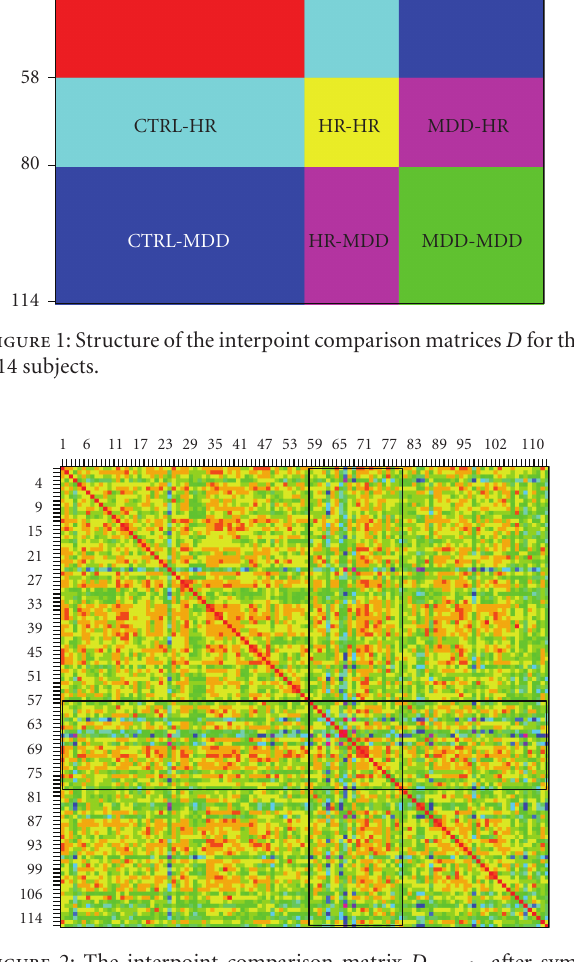
Figure 2: The interpoint comparison matrix D LM-Left , after sym- metrization, for the 114 subjects. The comparison values are color- coded, with red representing zero (e.g., the diagonal entries) to green representing large